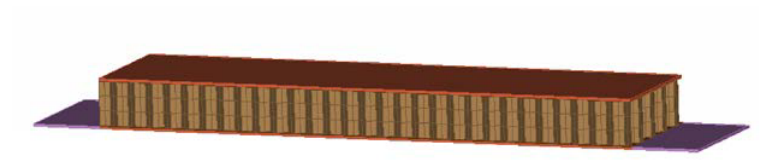
Fig. 4. Finite element of the honeycomb sandwich